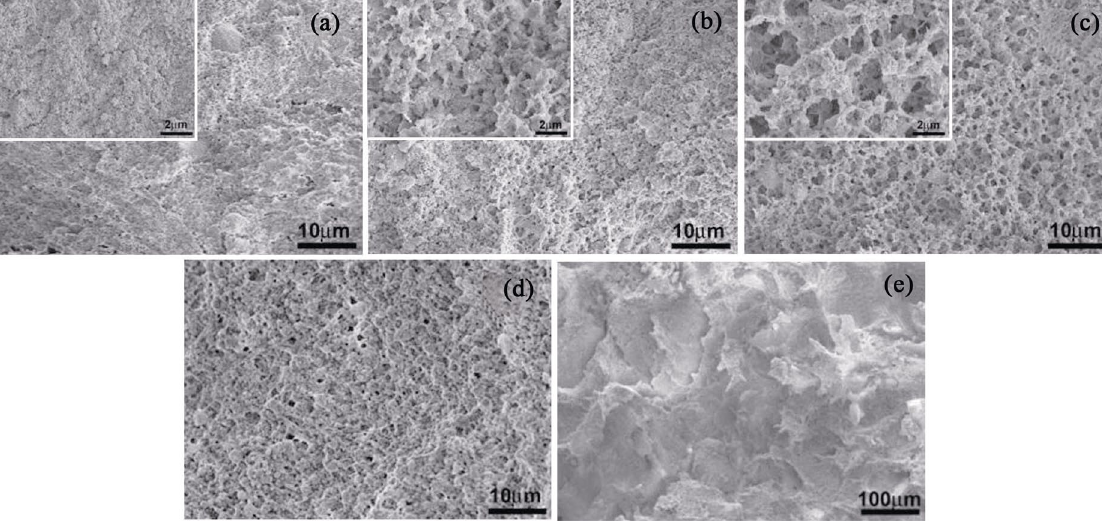
Fig. 2 SEM images of the gel-containing freeze HA green bodies. The content of HA in green bodies was: (a) 55 wt%, (b) 48 wt%, (c) 38 wt%, and (d, e) 23